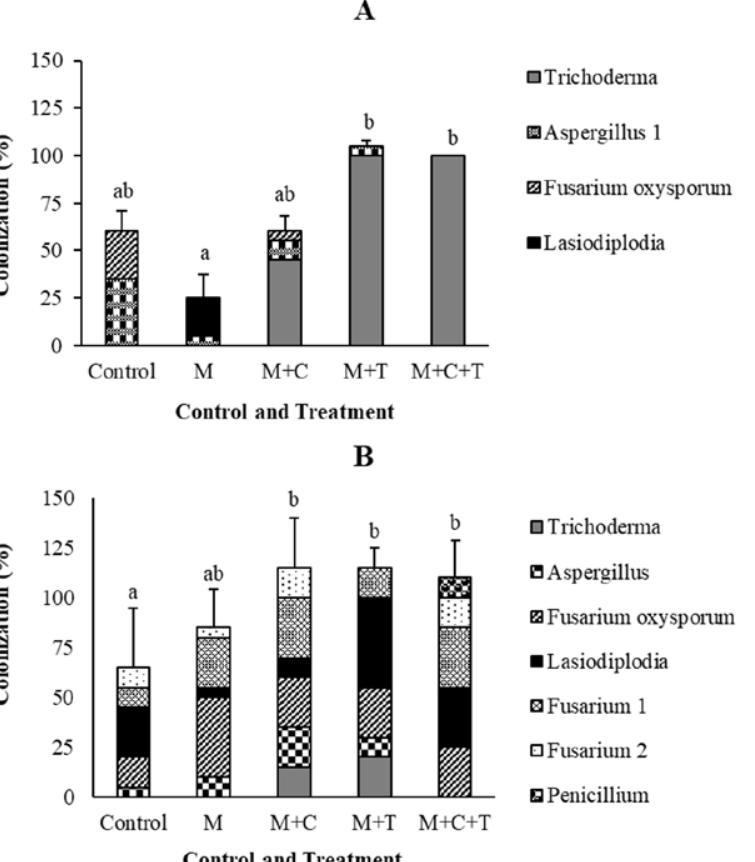
Fig. 4. Fungal colonization in leaf (A) and root (B) tissues observed at harvesting time, 63 days after treatment by mulch, mulch plus compost, mulch plus Trichoderma asperellum , and mulch plus compost plus T. asperellum . M = mulch, C = compost, T = T. asperellum . Means of colonization at the same time, followed by the same letter are not significantly different according to DMRT (p ≤ 0.05). Vertical bars show standard errors of